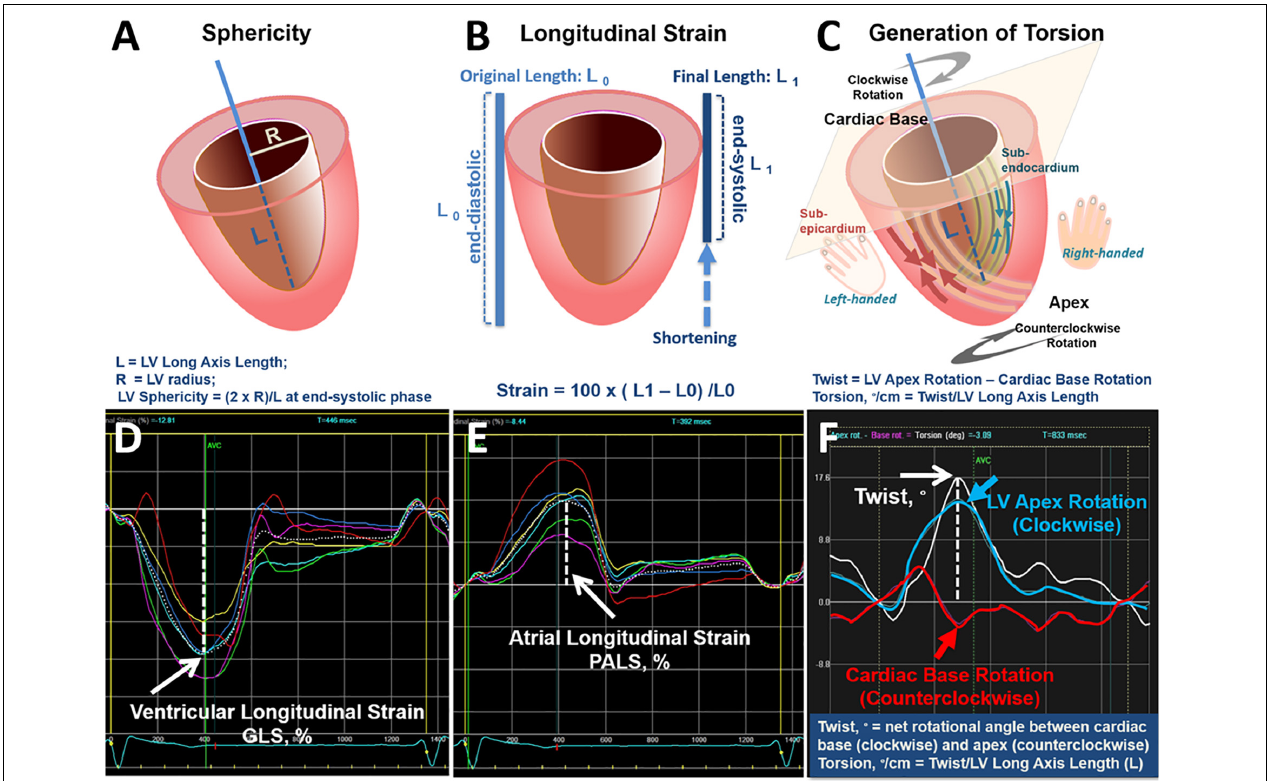
FIGURE 2 | Definition of sphericity, strain, torsion and cardiac mechanics. Definition of LV sphericity (A) and the fraction of longitudinal systolic shortening [expressed as percentage (%)] in terms of longitudinal strain (B) . When the heart contracts, the apex rotates in counterclockwise direction and the base rotates in clockwise direction. Cardiac torsion as defined by the net twist angle (from opposite rotational differences between base and apex) divided by LV length (L) (C) . Curves from tracing of ventricular (D) /atrial longitudinal strain (E) from any single plane and calculation of twist from automatic quantification algorithm in current study were displayed (F)